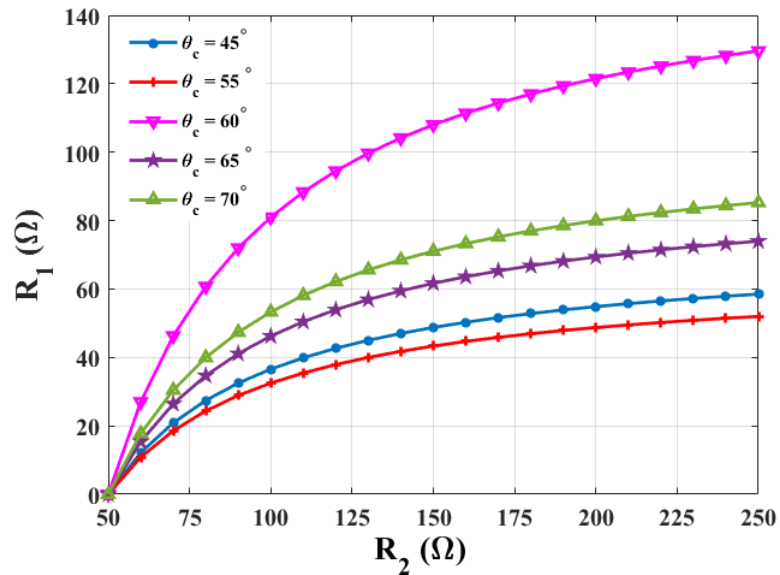
Figure 17. Relation between R 1 and R 2 for different θ c .